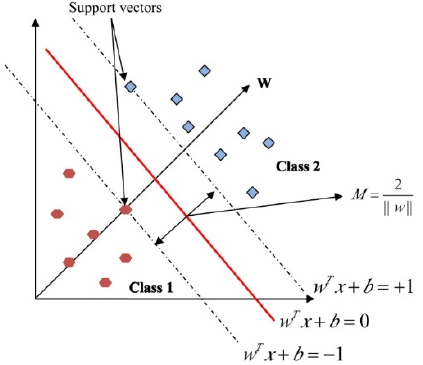
Figure 9. Illustration of hyperplane in linear SVM.